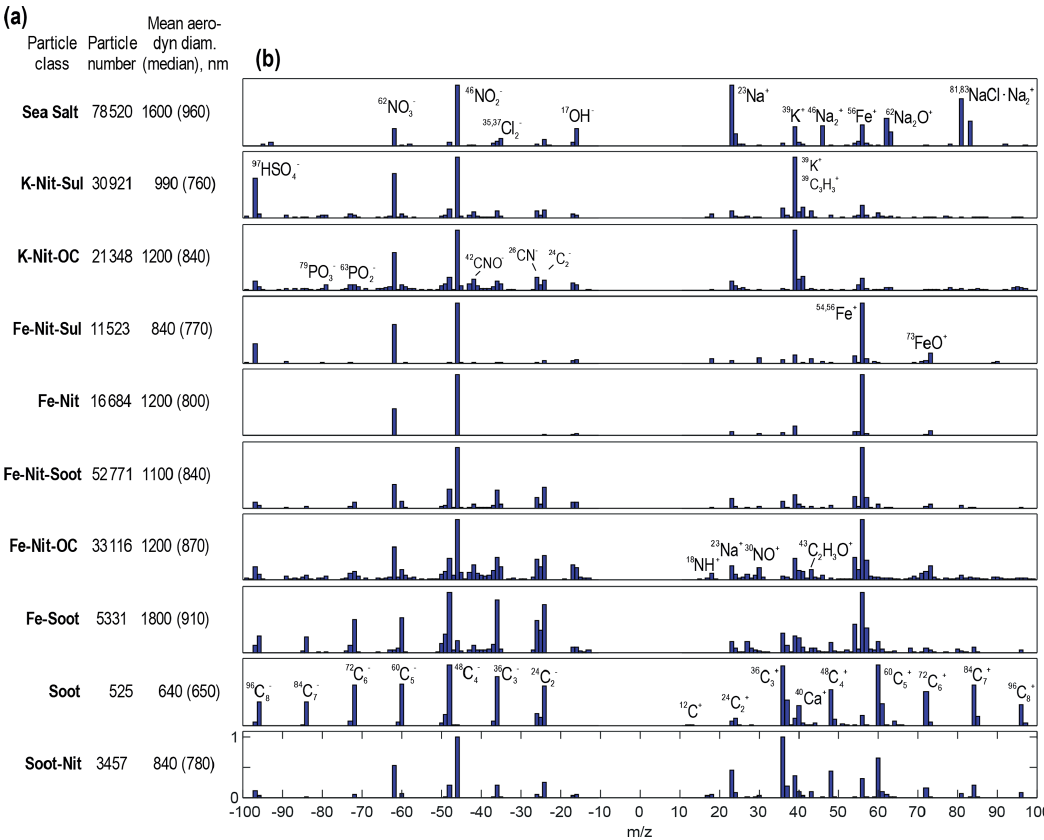
Figure 2. (a) Main particle classes obtained from ART-2a clustering of LDI mass spectra, their particle numbers and size. (b) Weight matrices (spectra of the cluster center) of negative ions (left) and positive ions (right) corresponding to average mass spectra from LDI. Note that iron is resonantly ionized and therefore efficiently detected. The top 300 ART-2a clusters that were manually merged to these classes can be downloaded from the data